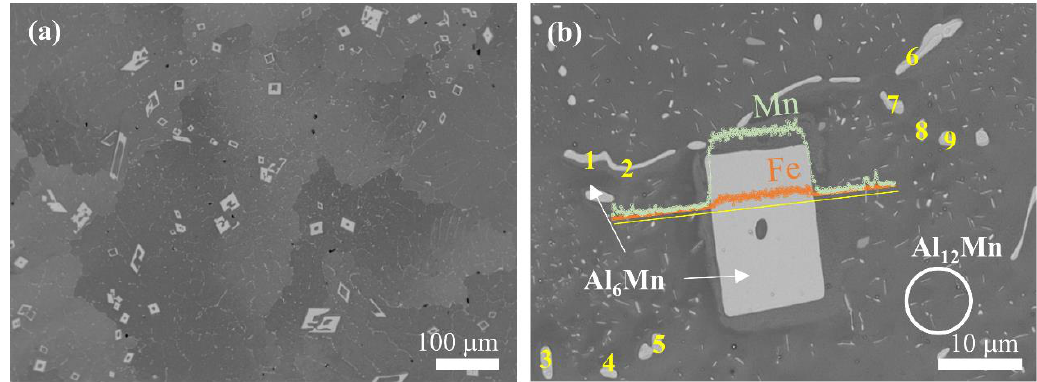
Figure 3. Backscattered electron (BSE) micrographs ( a ) low-magnification image ( b ) high-magnification image with energy-dispersive spectroscopy (EDS) linescan profiles along the yellow line.